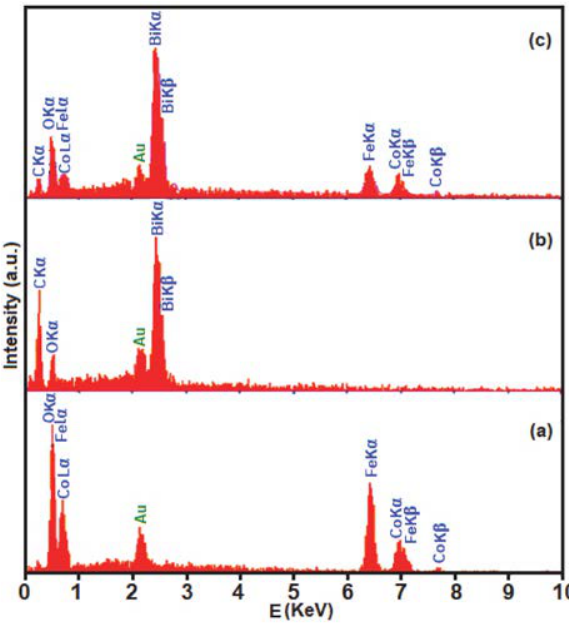
Figure 5. EDX spectra of (a) CoFe 2 O 4 , (b) Bi 2 O 2 CO 3 and (c) Bi 2 O 2 CO 3 /CoFe 2 O 4 30%